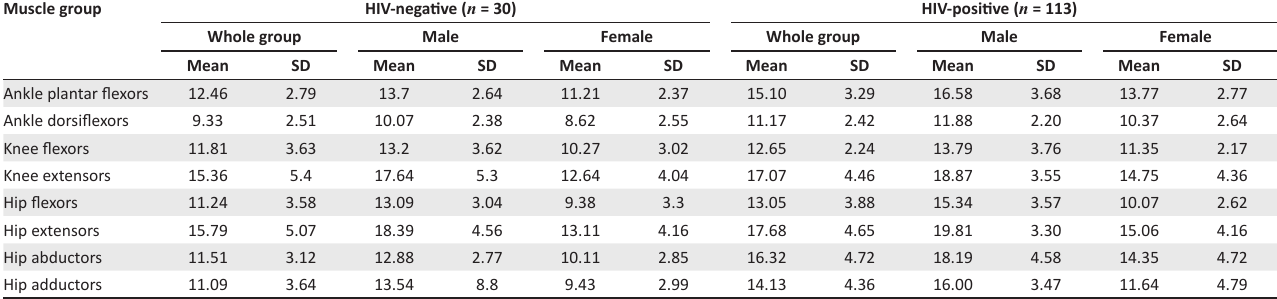
TABLE 2: Lower limb muscle strength kg/m 2 in HIV-positive participants on highly active antiretroviral therapy ( n = 113) and HIV-negative participants ( n = 30). Muscle group